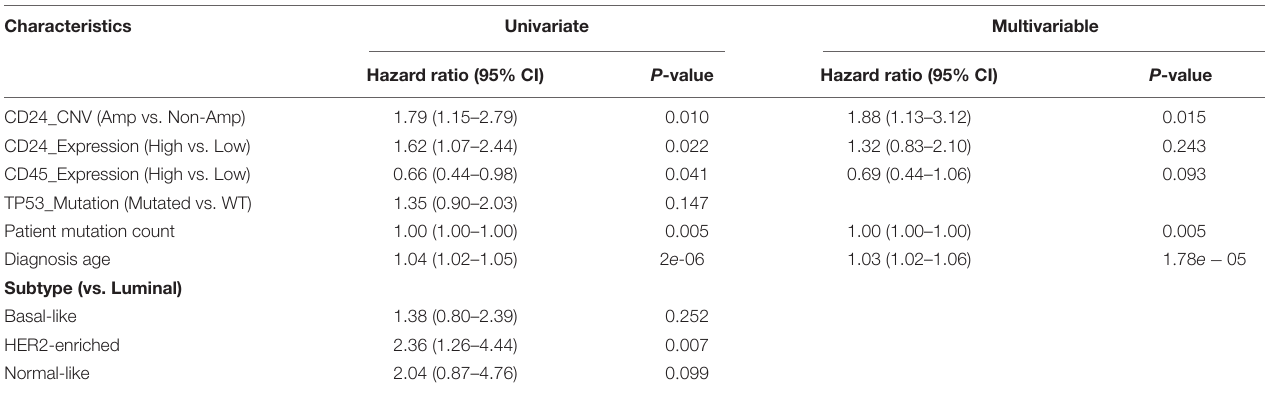
FIGURE 5 | CD24 amplification associated with basal-like subtype and poorer survival of BRCA patients. (A) Distribution of Basal-like samples among different CD24 copy number status subtypes of BRCA from TCGA patient cohort. (B) Mean value of Basal-like marker genes in BRCA. (C) The distribution plot of breast metastasis marker genes expression among BRCA patients with different CD24 copy number status. (D) Kaplan–Meier survival curves comparing the OS and disease-free survival time for different CD24 copy number subtypes in BRCA. Statistical significance was determined by the exact Fisher’s test in panel (A) , Wilcoxon test in panel (B) , One-way ANOVA in panel (C) , and log-rank test in panel (D) . TABLE 1 | Cox regression analysis in TCGA BRCA